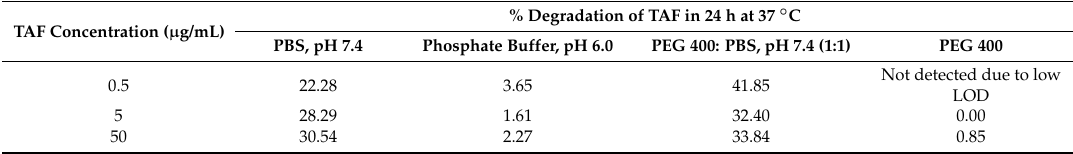
Table 6. Stability of TAF in different receptor